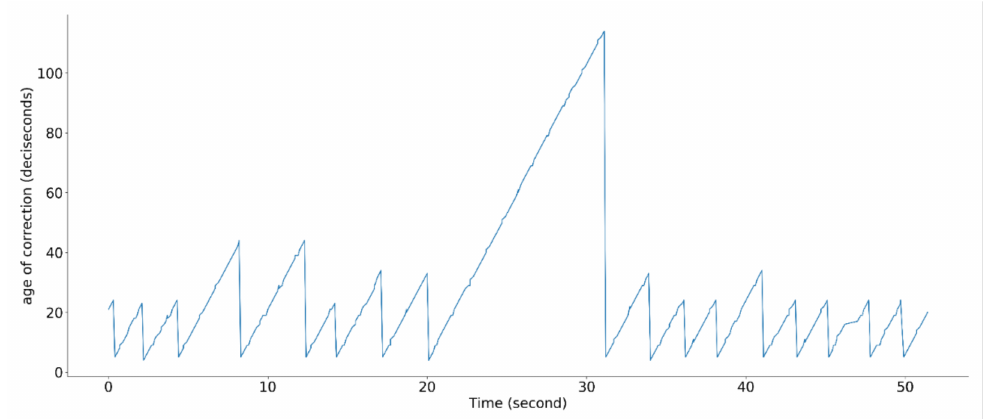
Figure 3. Age-of-correction